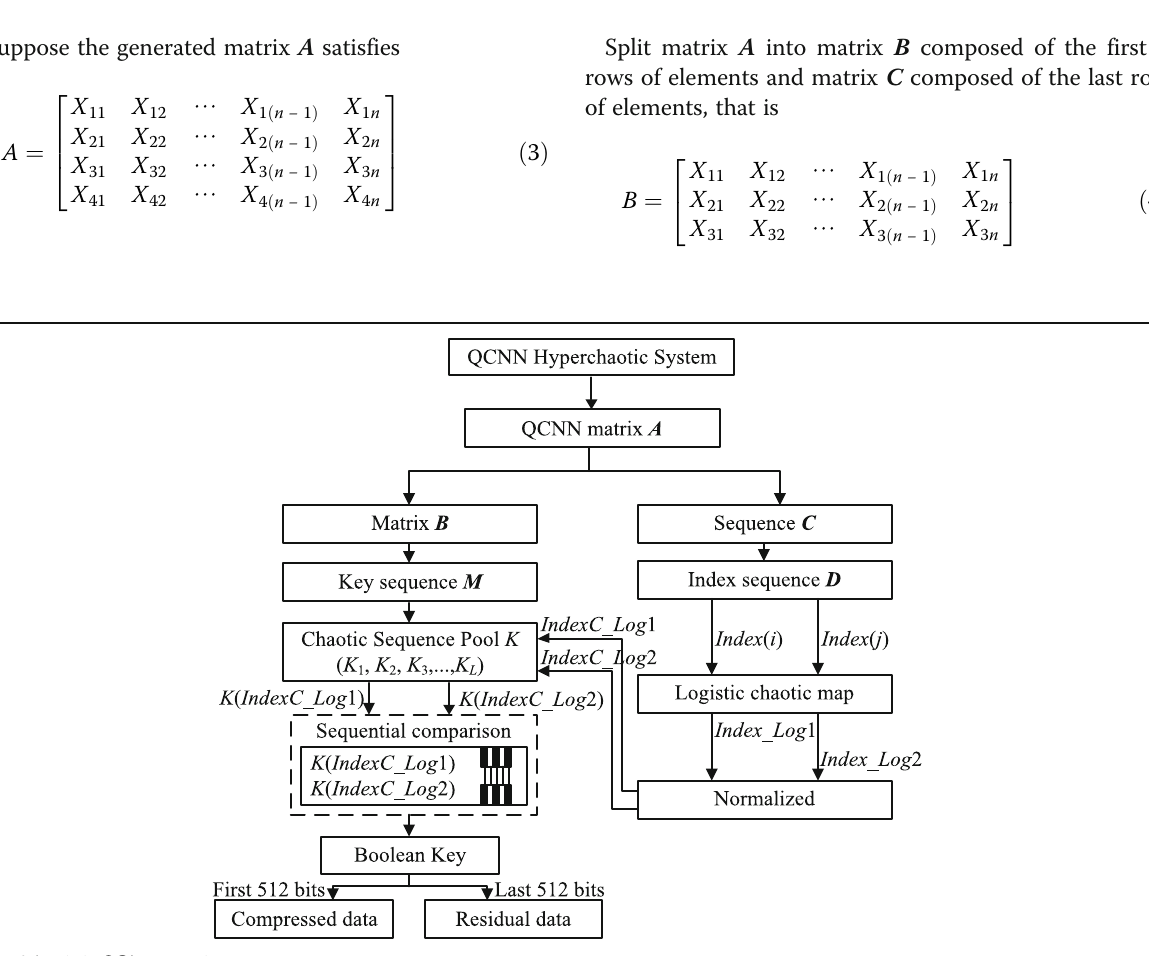
Fig. 2 Logistic-QCA encryption process